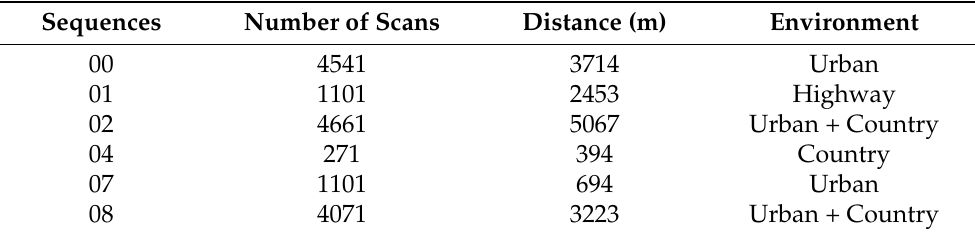
Table 1. The KITTI sequences used in our